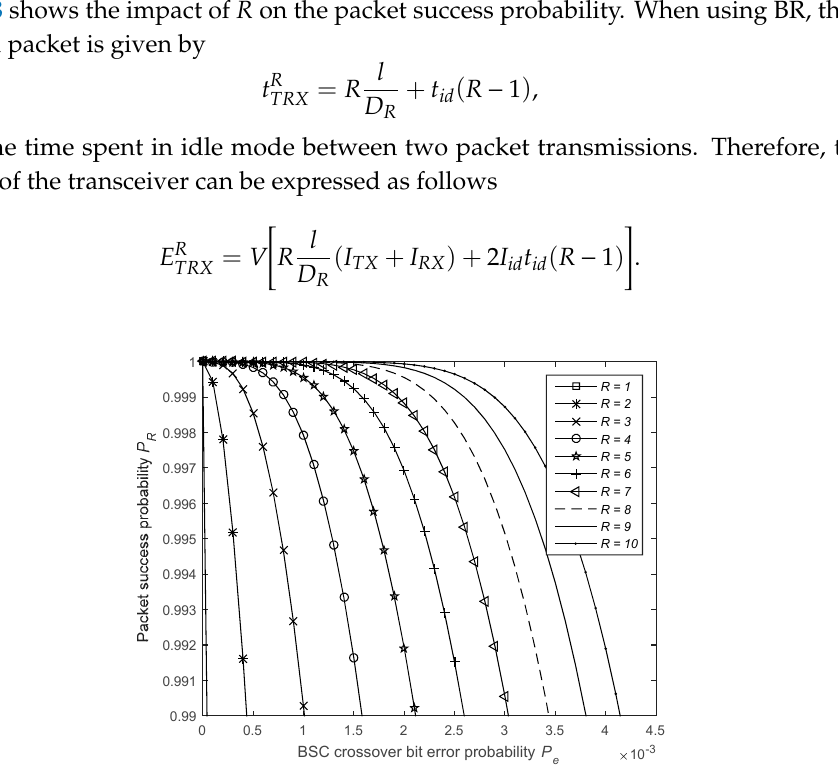
Figure 17. Impact of the 𝛽 (cid:3033)(cid:3045)(cid:3032)(cid:3032) parameter on the packet success probability.